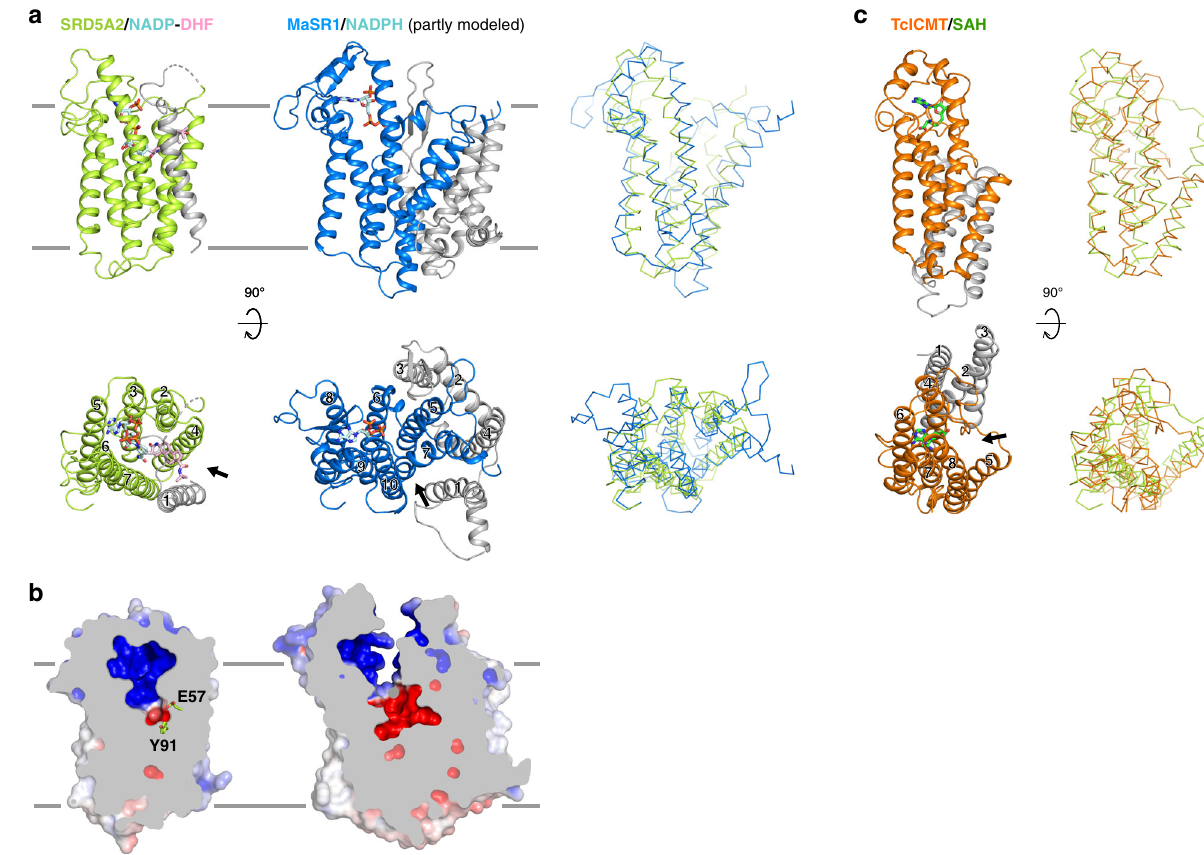
Fig. 6 Structural comparison of SRD5A2 with MaSR1 and ICMT. a Structural comparison of the transmembrane regions of SRD5A2 and MaSR1 (PDB ID: 4QUV). The core transmembrane regions in SRD5A2 and MaSR1 that can be structurally aligned are shown as colored ribbons, while the rest parts are shown as gray ribbons. The right panel shows the superimposition of SRD5A2 and MaSR1. b Occluded and exposed ligand-binding cavities in SRD5A2 and MaSR1, respectively. c Structural comparison of the transmembrane regions of SRD5A2 and ICMT (PDB ID: 5V7P). The core transmembrane region of ICMT that can be well aligned to SRD5A2 is colored orange. The cofactor of ICMT, SAH, is colored green. The right panel shows the superimposition of SRD5A2 and ICMT. The potential substrate entry ports in all three enzymes are indicated by proteins soluble. Glycerol was used to stabilize the protein during solubilization. CHS was added in case the protein needs cholesterol to be stable. Iodoacetamide was used to prevent protein aggregation due to nonspeci fi c disul fi de bonds. Leupeptin and benzamidine were used as protease inhibitors. Salt active nuclease was used to degrade DNA to lower viscosity of solubilized materials.